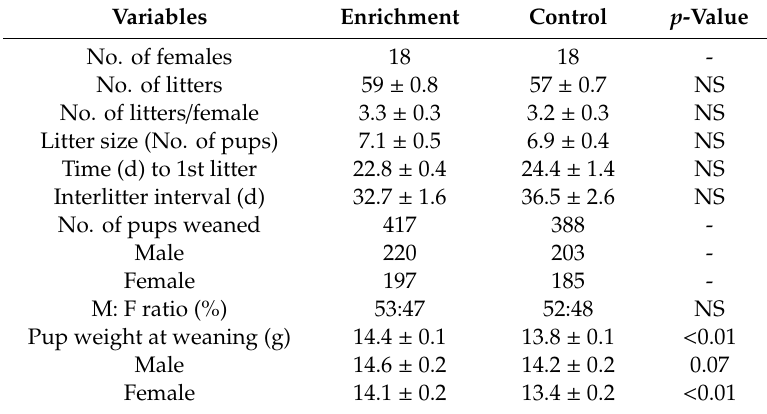
Table 1. Reproductive outcomes of breeder Swiss Webster mice subjected or not to enrichment